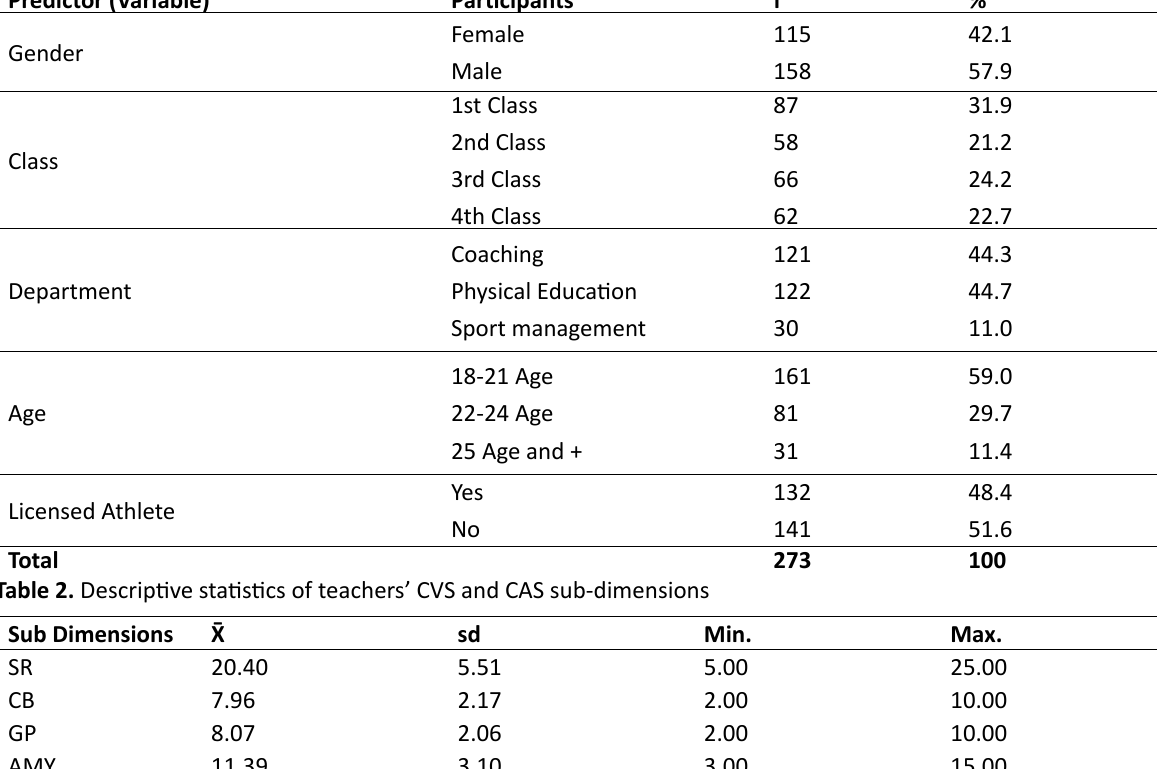
Table 1. Participants’ Demographic Characteristics